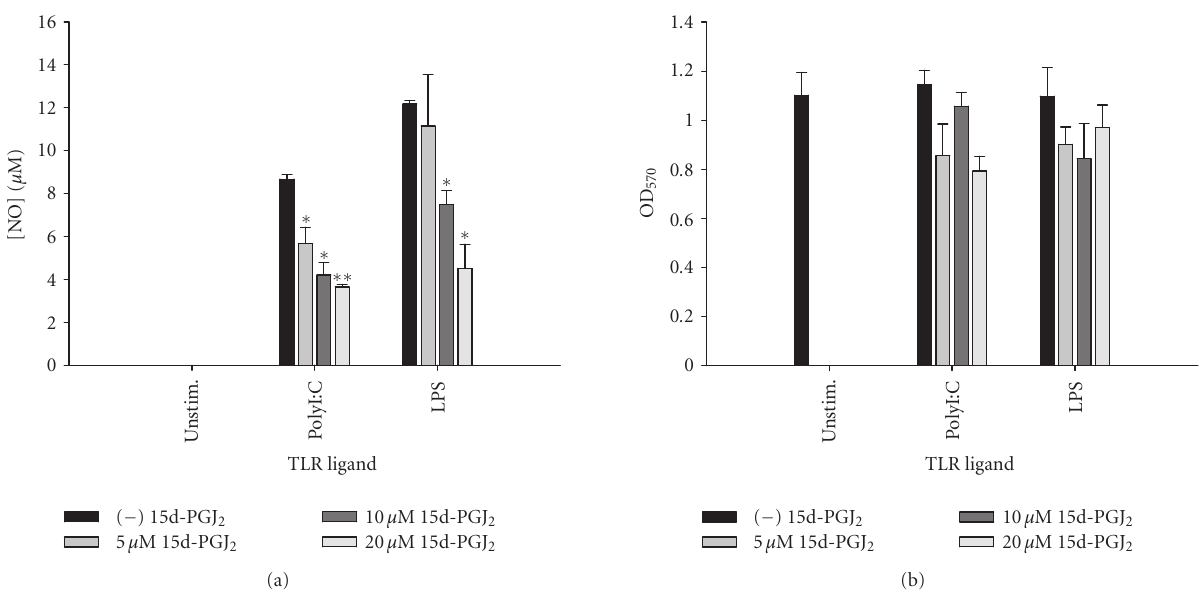
Figure 9: 15d-PGJ 2 attenuates NO production by astrocytes in response to polyI:C and LPS stimulation. Primary astrocytes were plated at 1 × 10 5 cells/well in 96-well plates and incubated overnight. The following day, cells were pretreated for 1 hour with the indicated concentrations of 15d-PGJ 2 prior to the addition of polyI:C or LPS. Cell-conditioned supernatants were collected at 24hours following TLR ligand exposure, whereupon NO levels were determined by the Griess reagent (a). The e ff ects of 15d-PGJ 2 on astrocyte viability were assessed using an MTT assay (b). Significant di ff erences between astrocytes treated with TLR ligands alone versus TLR ligands + 15d-PGJ 2 are noted with asterisks ( ∗ P < . 05; ∗∗ P < . 001). Results presented are representative of two independent experiments.